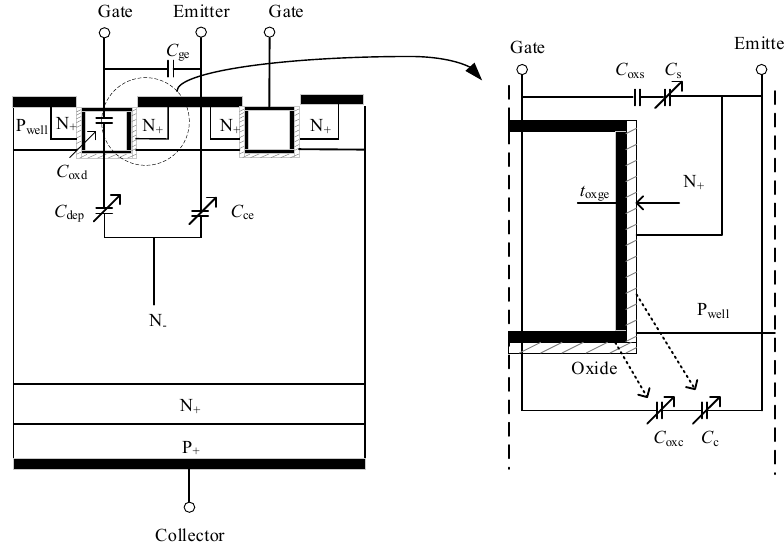
Figure 6. IGBT internal equivalent capacitance diagram.